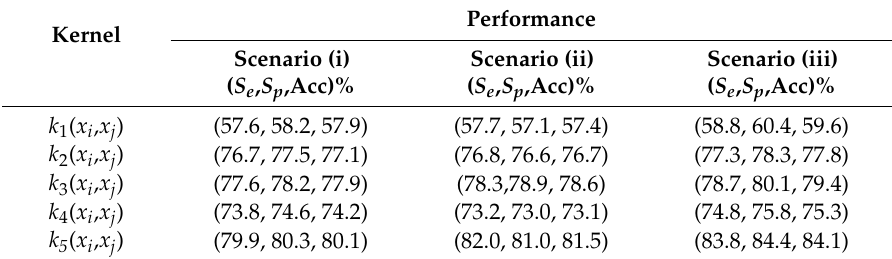
Table 3. Analysis of traditional kernels in organ inflammation